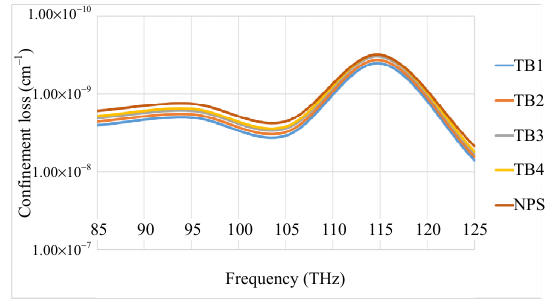
Fig. 11 CL of the proposed sensor for various tuberculosis-infected samples versus X at 2.2